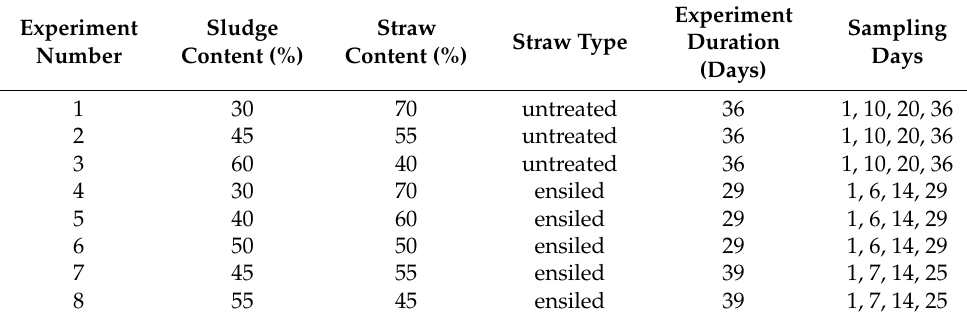
Table 1. Plan of